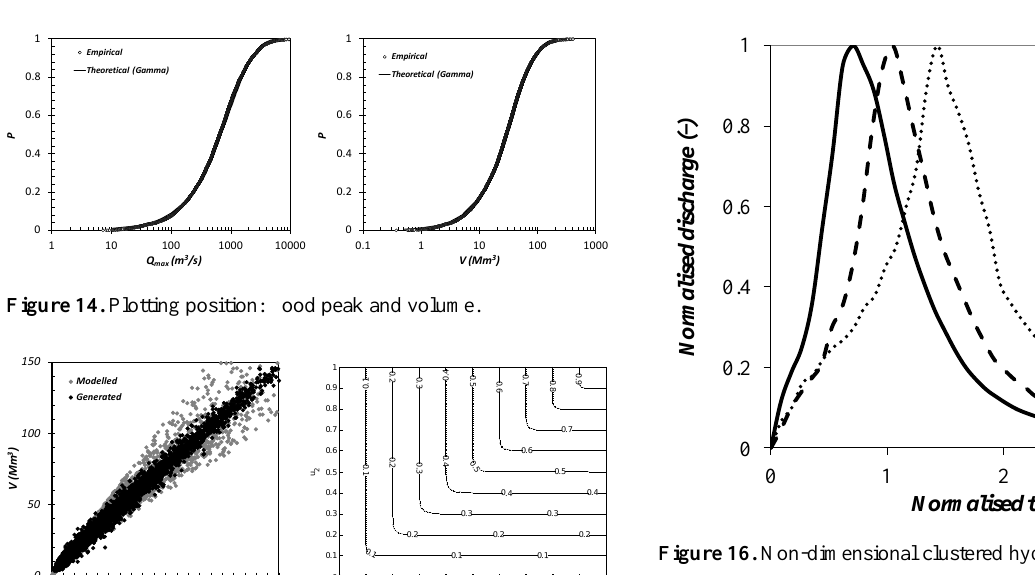
Figure 13. Normalised scatter plot for the different copula models considered. The “empirical” points represent the pairs coming from the R–R model.